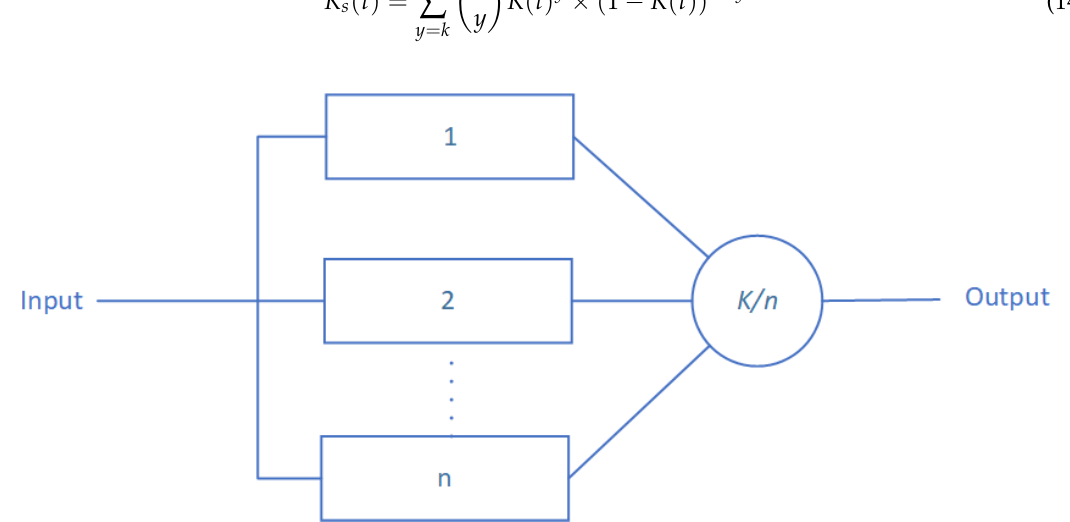
Figure 4. A k -out-of- n structure architecture according to the RBD